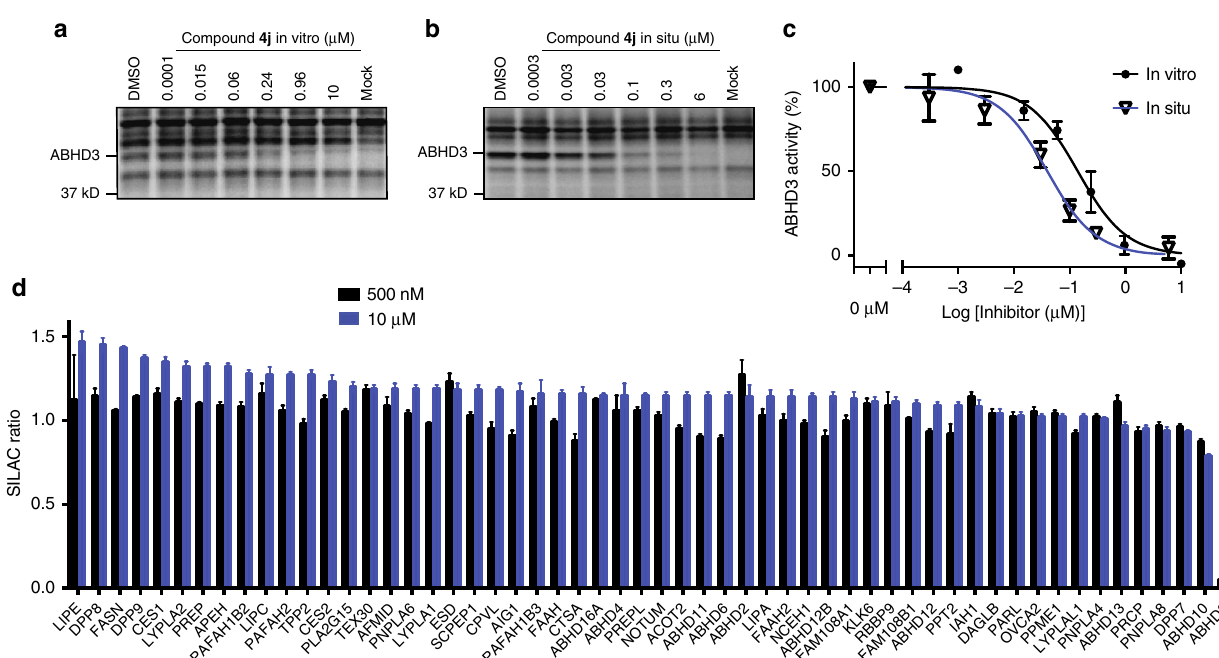
Fig. 5 Compound 4j is a potent and selective ABHD3 inhibitor. a , b ABPP gels of HEK 293T cells overexpressing human ABHD3 treated with compound 4j ( a ) in vitro (30 min, 37 °C) or ( b ) in situ (2 h, 37 °C). c IC 50 curves for the aforementioned in vitro and in situ 4j treatments. The data represent average values ± S.E.M. values for three independent experiments per group. d Quantitative ABPP-SILAC analysis of SW620 cells treated in situ with DMSO (heavy-isotopically labeled cells) or 4j (0.5 or 10 µ M, 2 h; light-isotopically labeled cells). After in situ treatments, heavy and light cells were lysed, treated with the broad-spectrum, serine hydrolase-directed activity-based probe FP-biotin (6 µ M, 1 h, RT), combined and processed for quantitative MS-based analysis, as described [41] . ABHD3 shows complete (95+%) inhibition at both concentrations and 4j appears to have no major off-targets. The data represent average values ± S.E.M. values for quanti fi ed peptides per protein derived from two independent experiments